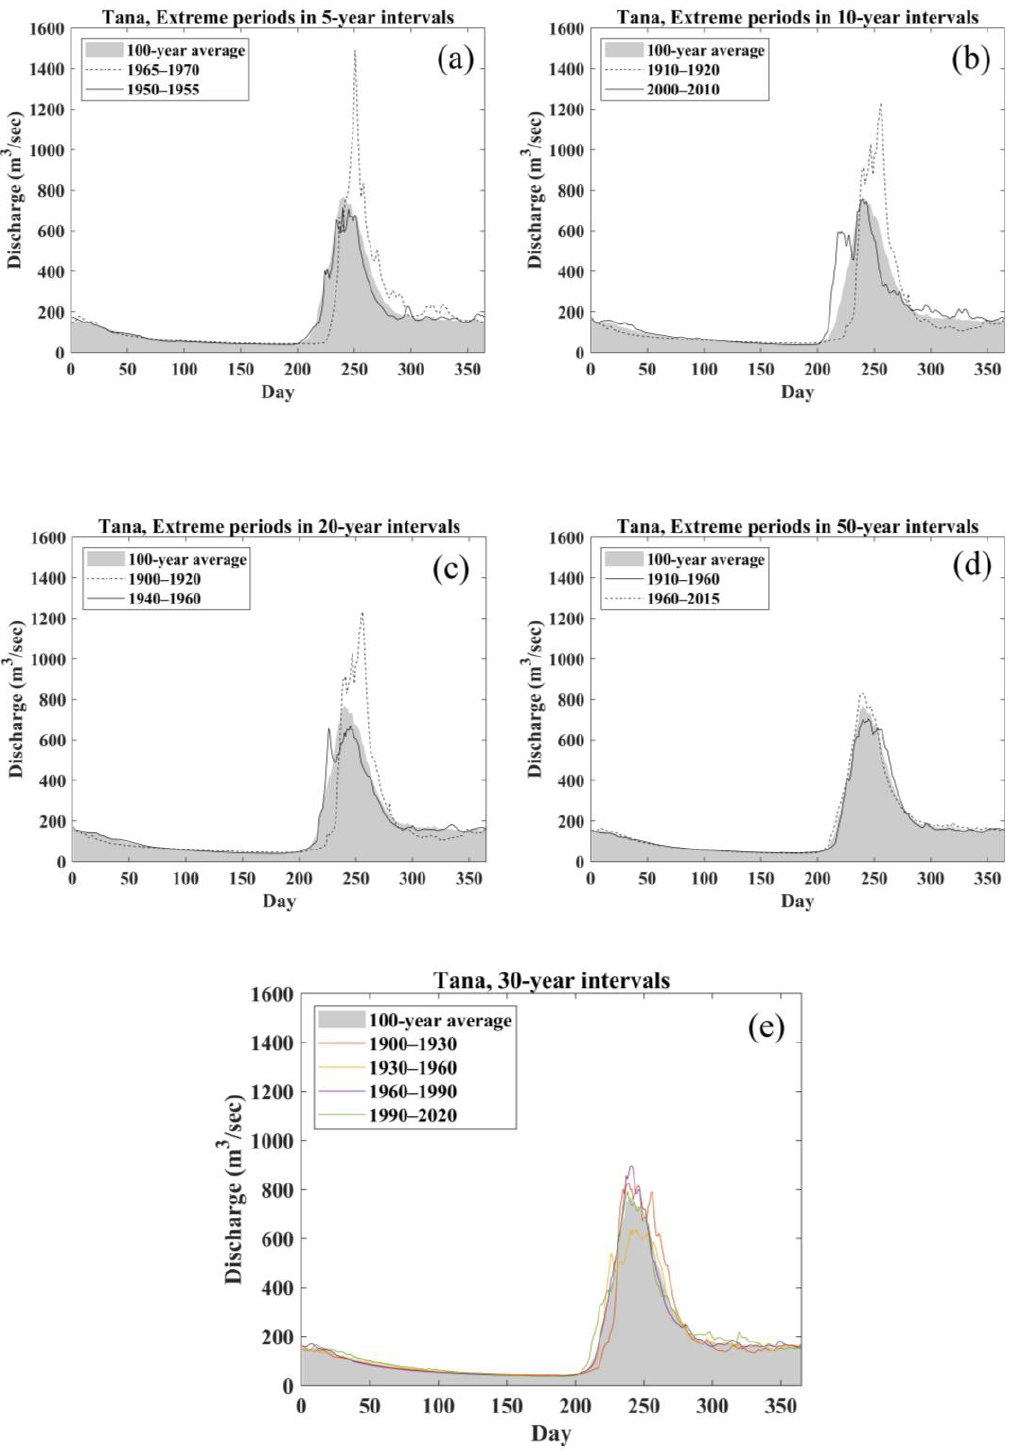
Figure 4. Extreme average annual discharge time series for different 30-year periods ( a – e ) for the Tana River.